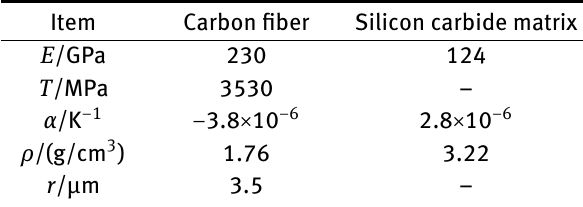
Table 1: Material parameter of fiber and matrix Item Carbon fiber